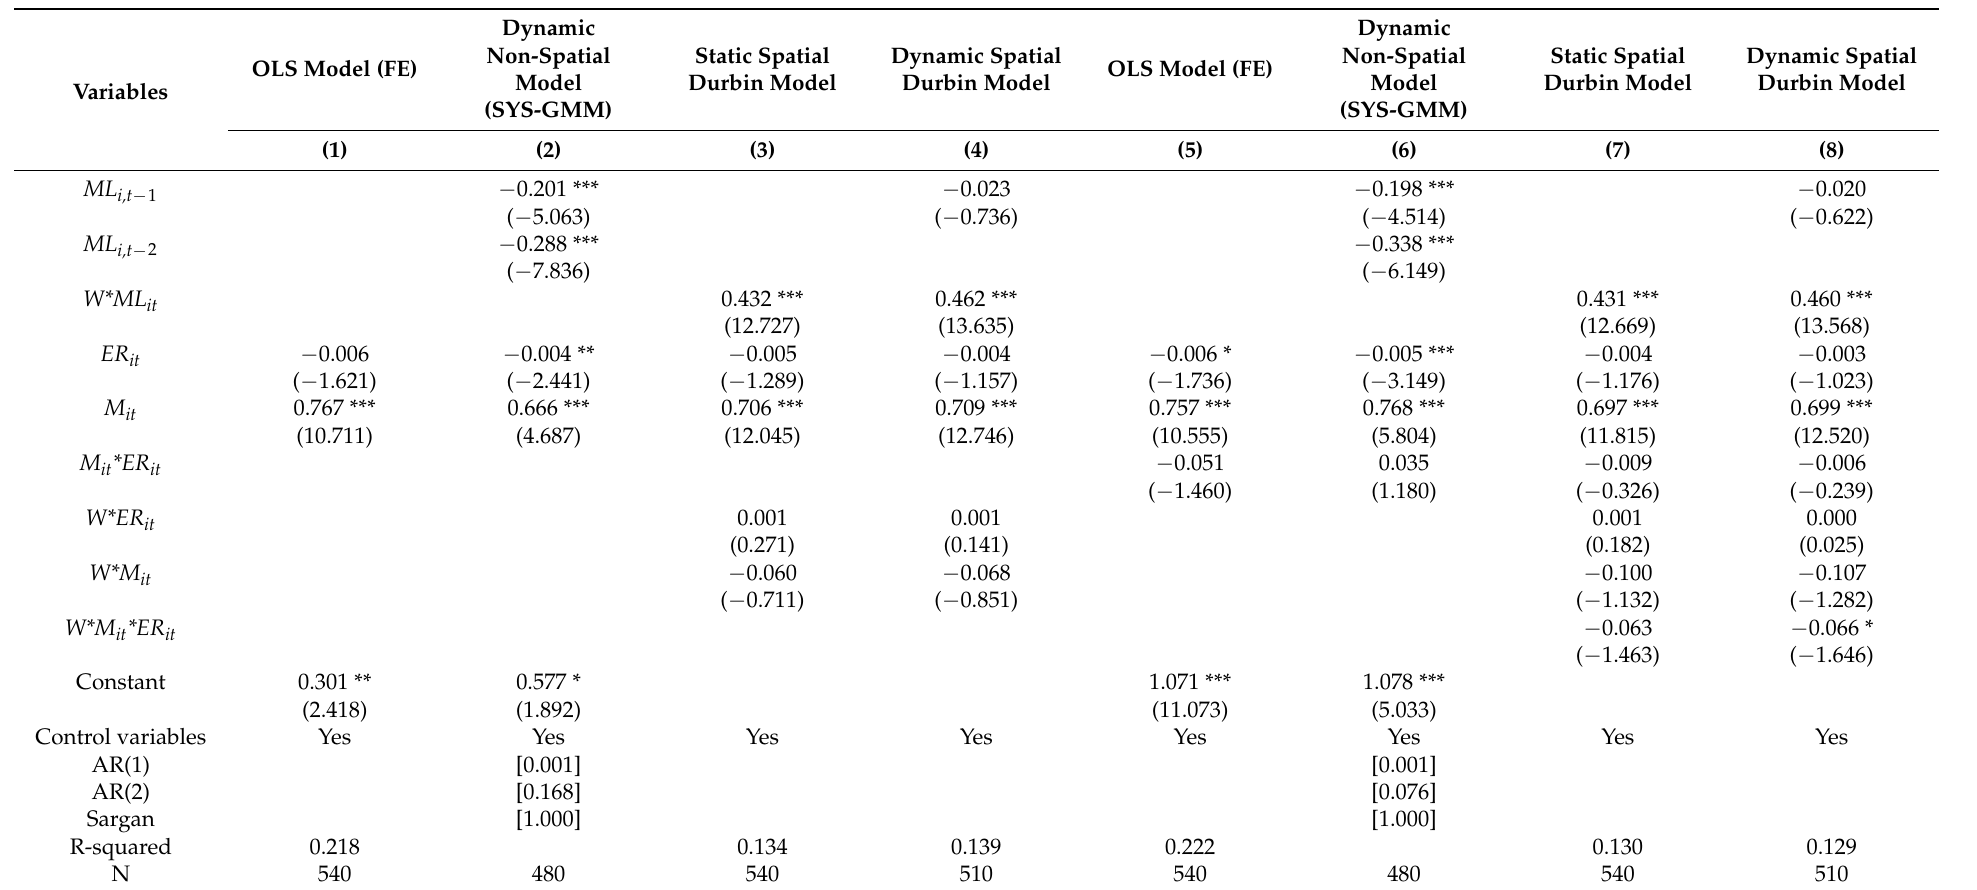
Table 3. The moderating results of efficiency change for the nexus between command–control environmental regulation and green